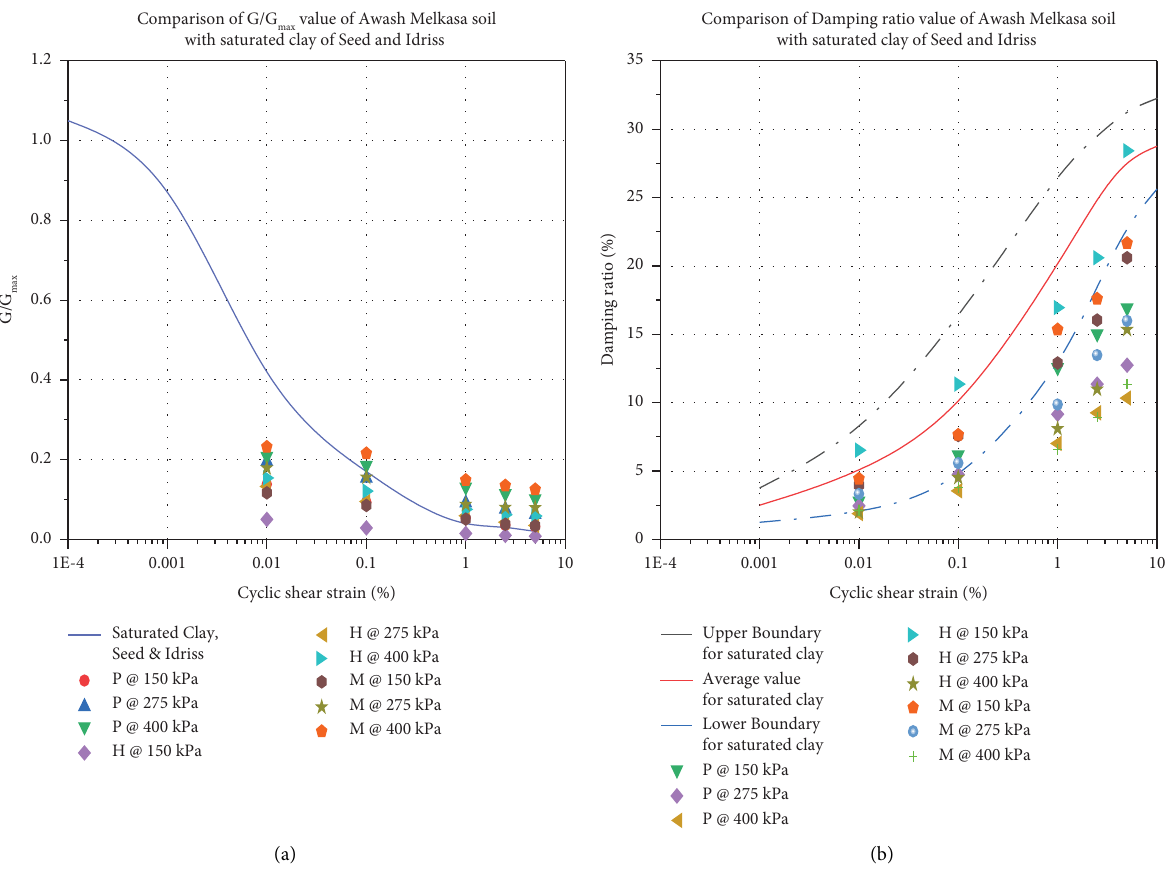
Figure 12: Comparison of Awash Melkasa soil with the saturated clay soil of Seed and Idriss: (a) G / G